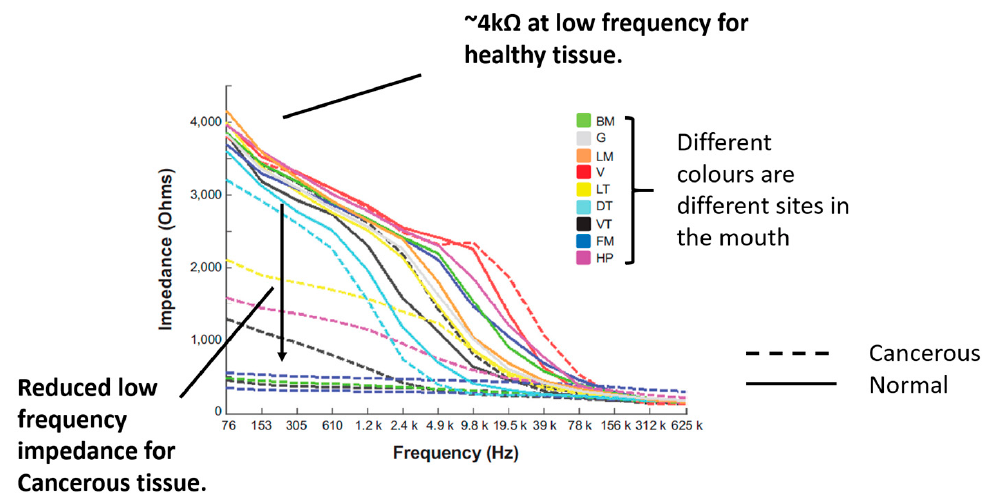
Figure 2. Measured impedance spectra of various oral sites and diagnoses. Adapted from [15] ( International Journal of Nanomedicine 2014 9 4521–4532. Originally published by and used with permission from Dove Medical Press Ltd.). Note the severe OPMD cases in the present study are the closest match to confirmed cancerous tissue considered by the previous work above.